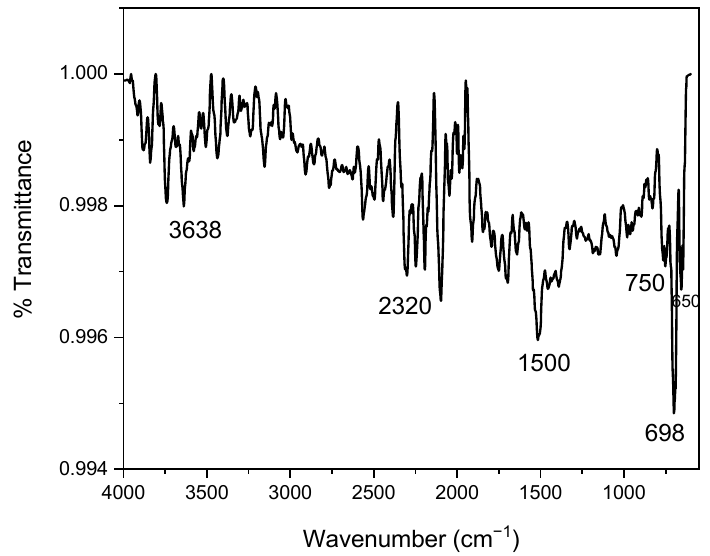
Figure 5. FTIR spectrum of designed photocatalyst depicting its characteristic functional groups.